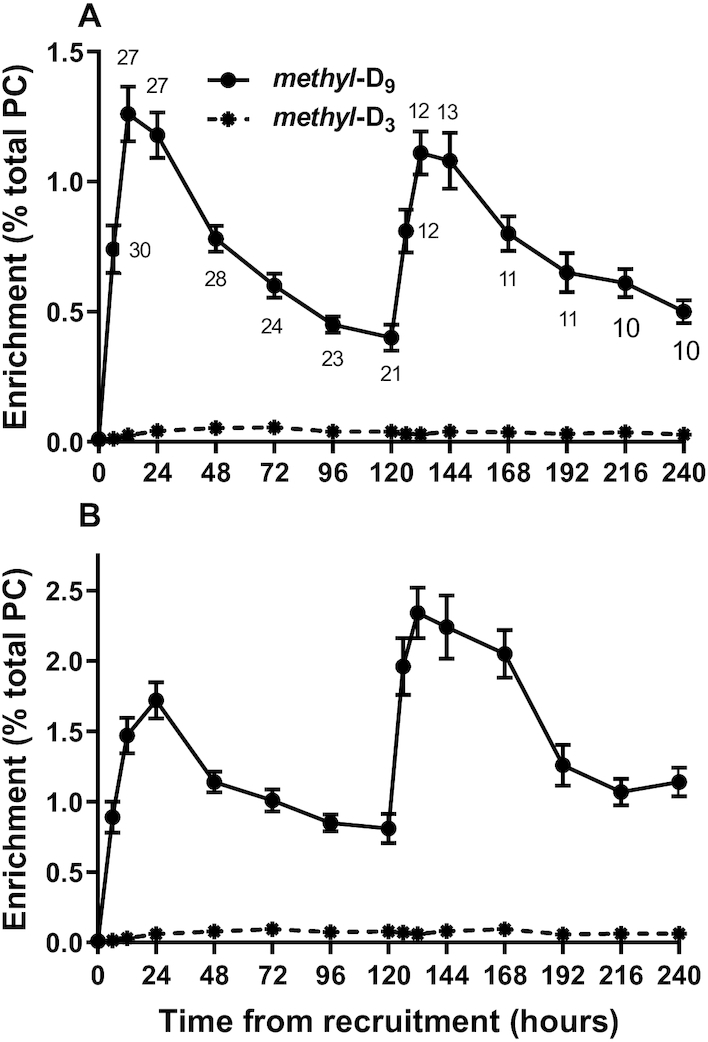
Incorporation of stable isotope–labeled choline into plasma PC in preterm infants. (A) The fractional enrichment of methyl-D9-PC (solid line, mean ± SEM) synthesized by the CDP-choline pathway and of methyl-D3-PC synthesized by the PEMT pathway (dashed line, mean with SEM smaller than symbol). There were 31 infants at t = 0, and numbers of infants at each time point are indicated on the figure. (B) The same results as in panel A after normalization to the initial concentration value using the variation in PC concentration with time detailed in Figure 2B. CDP-choline, cytidine diphosphocholine; PC, phosphatidylcholine; PEMT, phosphatidylethanolamine N-methyltransferase.